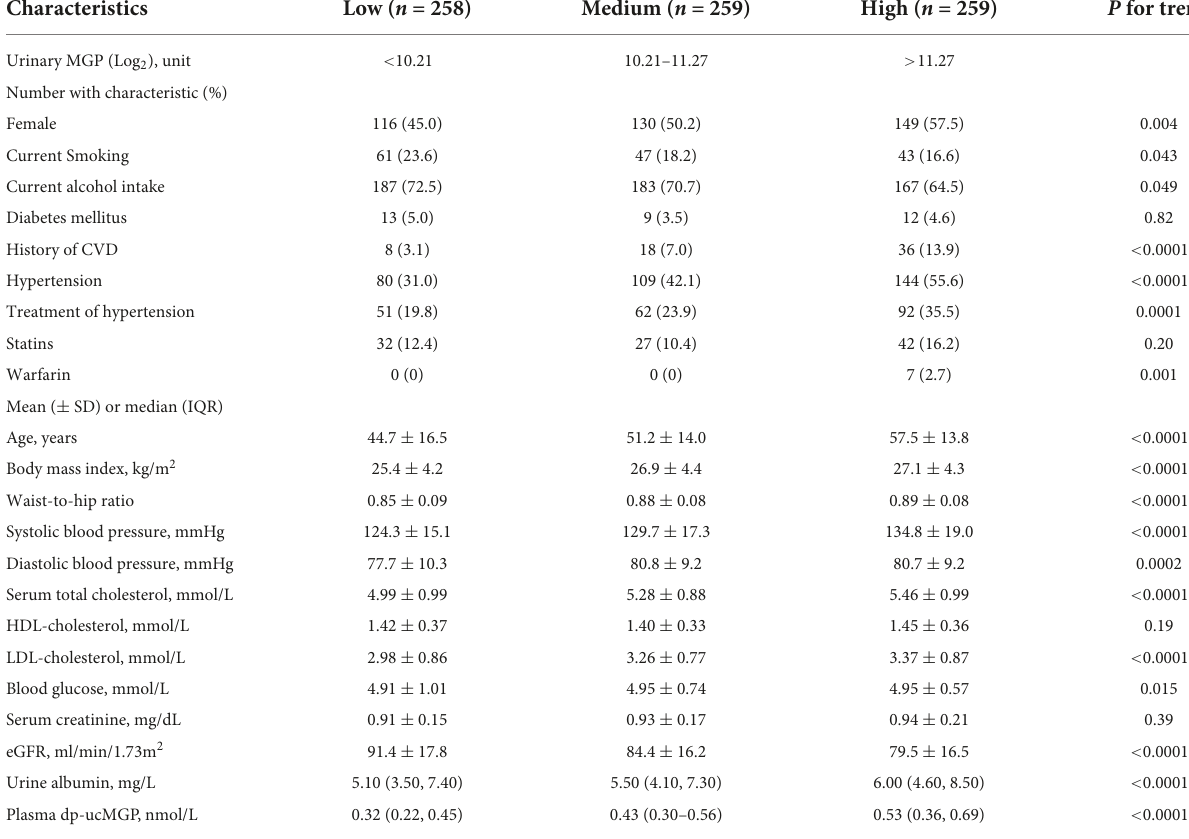
TABLE 1 Participant characteristics and classified according to one-third of urinary matrix Gla protein (MGP). Characteristics Low ( n = 258) Medium ( n = 259) High ( n = 259)